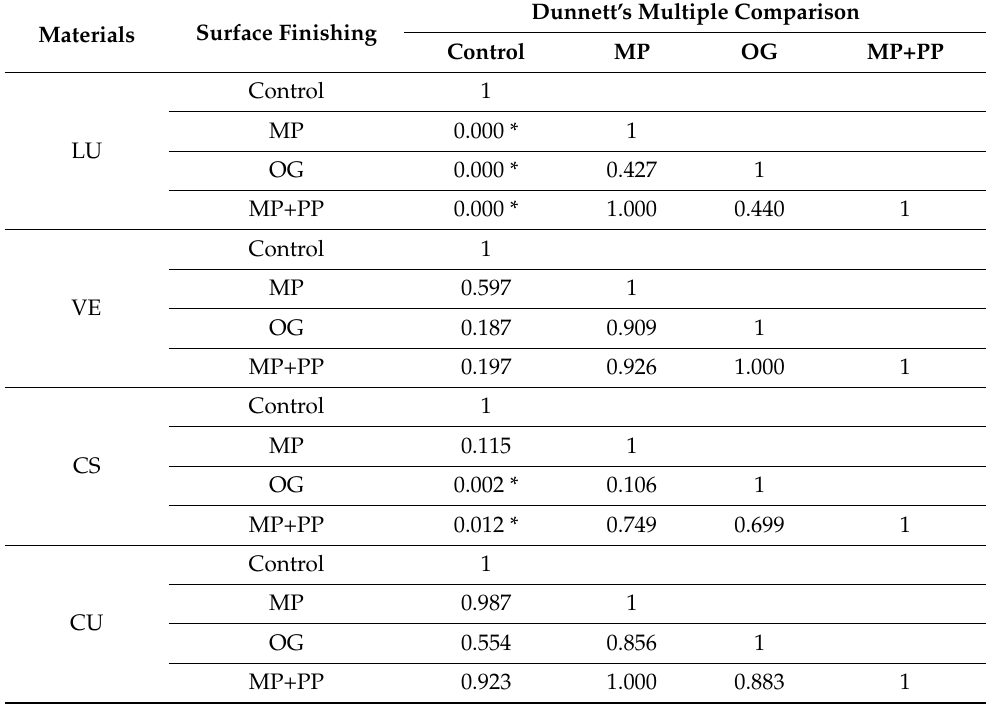
Table 5. Post hoc multiple comparisons for ∆ E of the materials after surface finishing.